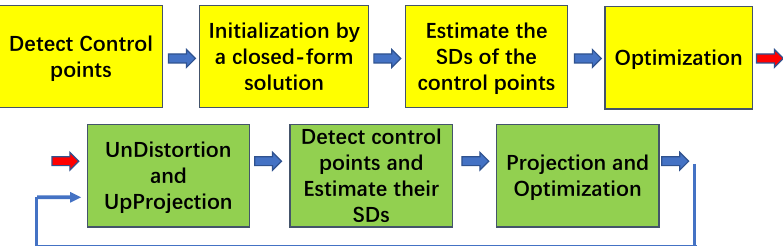
Figure 6. An illustration of the pipeline of our method. The four yellow blocks indicate the stan- dard parts of the calibration process and the three green blocks denote the iterative parts of the calibration